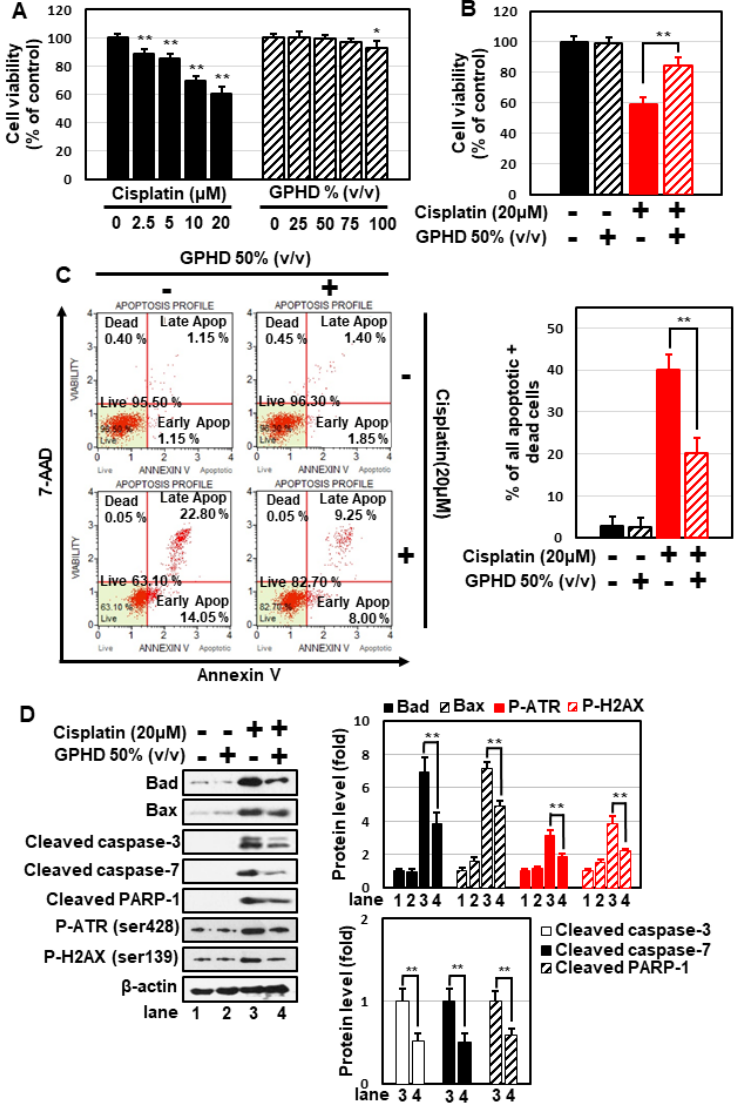
Figure 1. Preventive effects of GPHD on cisplatin-induced cytotoxicity in HEK293 cells. HEK293 cells were treated with the indicated concentration of cisplatin and/or GPHD for 24 h, then cell viability assays ( A , B ), FACS analysis of 7-AAD and annexin V double-positive stained cells ( C ), and Western blotting ( D ) were performed. The results shown are representative of the three independent experiments. p ‐ value < 0.05 was considered statistically significant; individual p ‐ values (* p < 0.05; ** p < 0.01) are indicated in figures.